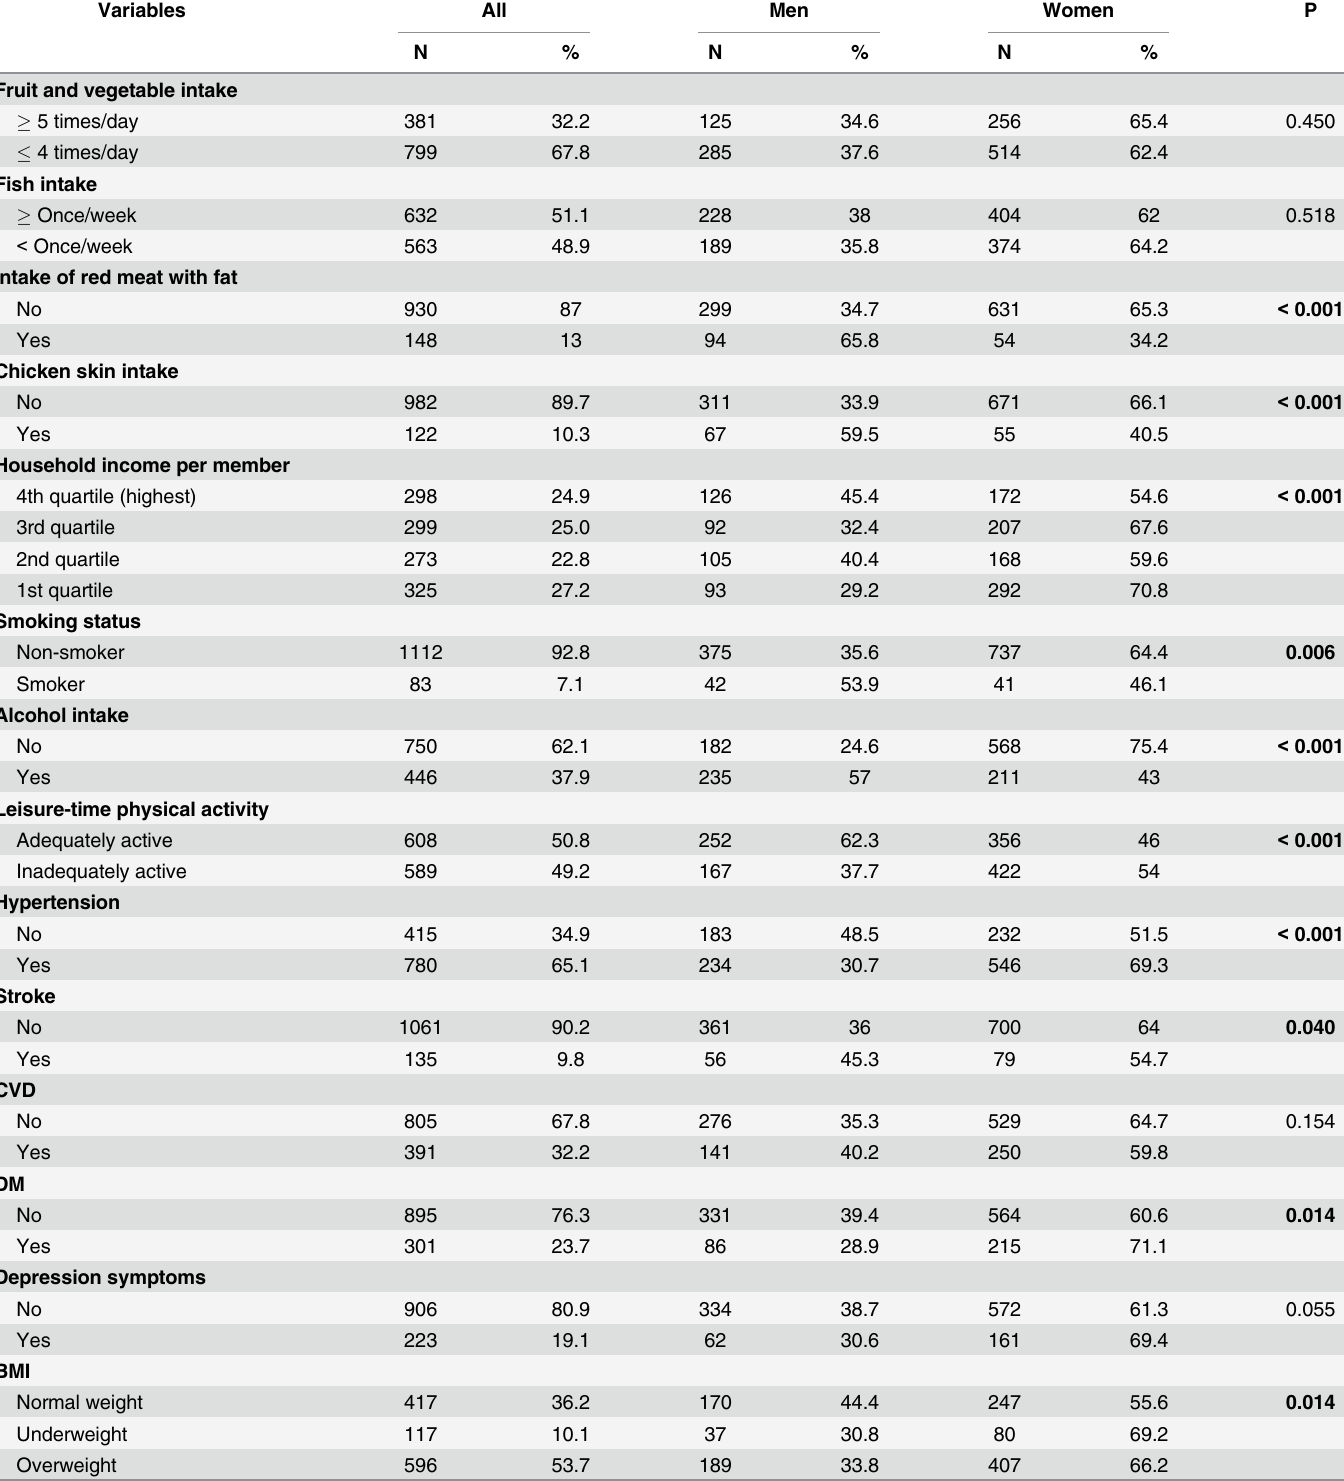
Table 1. Sample characteristics stratified by gender. EpiFloripa Elderly , 2013 – 2014. Variables All Men